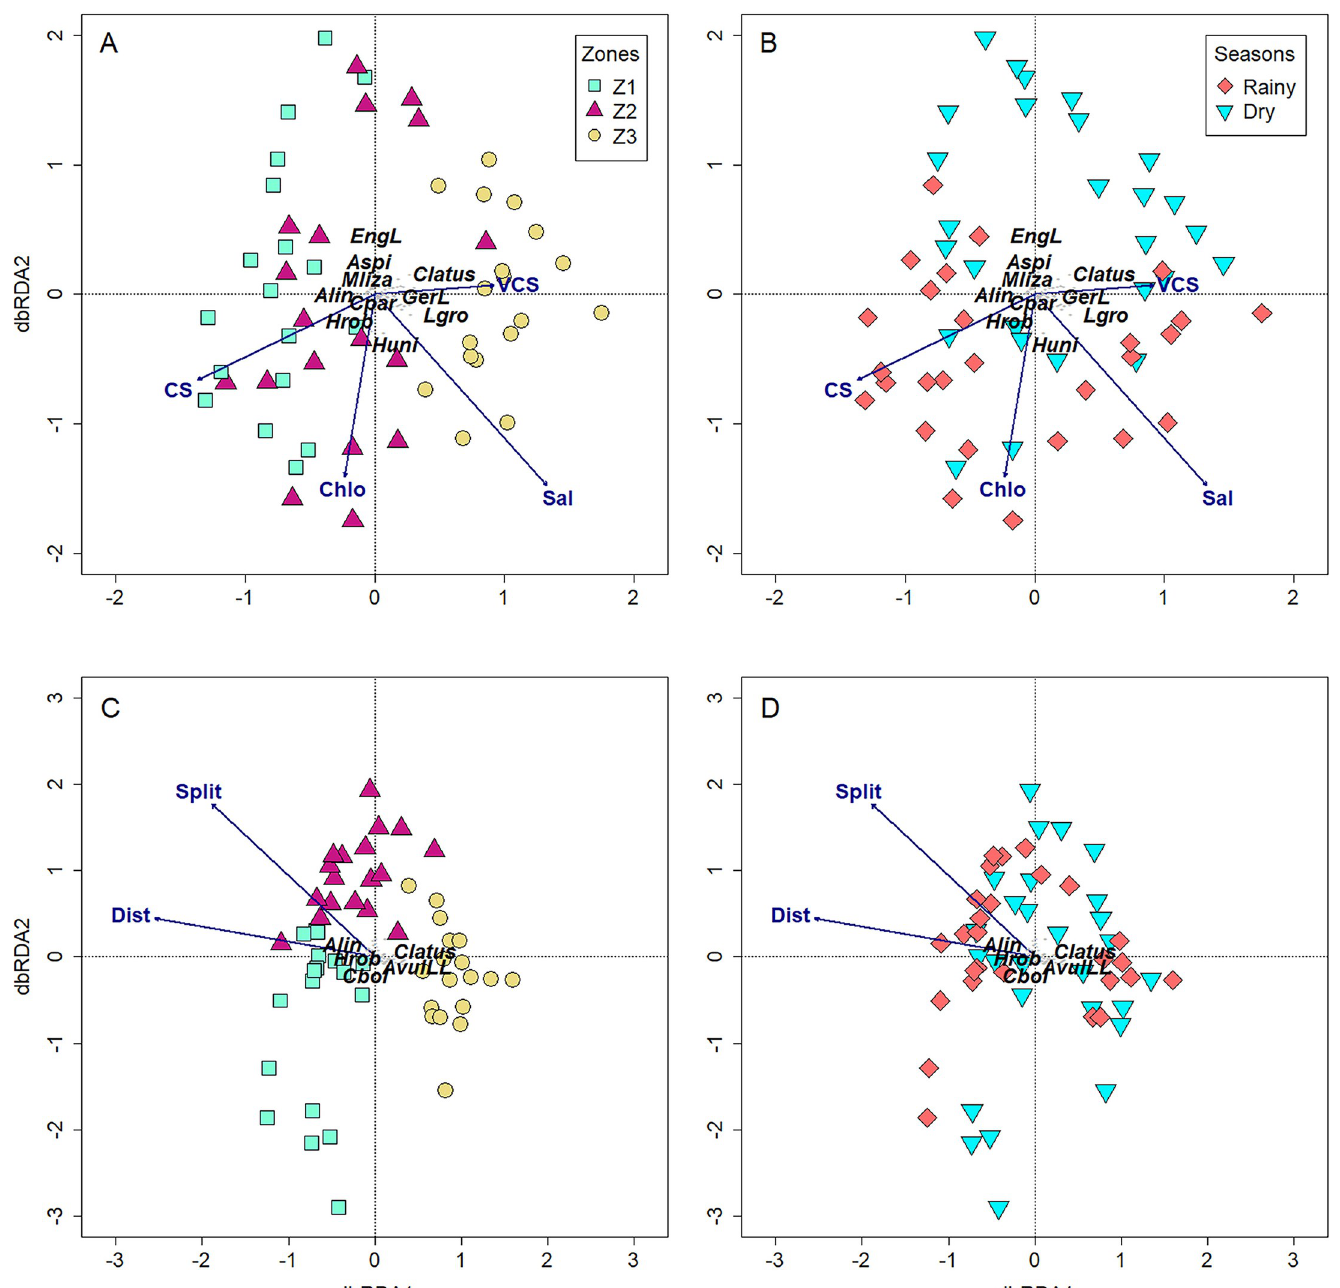
Fig 4. db-RDA ordinations summarizing relationships among environmental (A and B) and landscape (C and D) variables, separately, with fish assemblage β - diversity. Zones: Z1 = aquamarine, Z2 = violet and Z3 = yellow. Seasons: Rainy = red and Dry = lightblue. Variable were coded either by first 3–4 letters or by initials: Chlo = Chorophyll a , CS = Coarse sand, Dist = Distance from the estuary mouth, Sal = Salinity, VCS = Very coarse sand. Species were coded by the first letter of genus or species and first 3 letters of the epithets, except when the epithets were short, then, the names were completely adopted: Alin = Achirus lineatus , AvulLL = Albula vulpes leptocephali larva, Aspi = Anchoa spinifer , Clatus = Caranx latus , Cpar = Centropomus parallelus , Cbol = Ctenogobius boleosoma , EngL = Engraulidae larva, GerL = Gerreidae larva, Hrob = Hyporhamphus roberti , Huni = Hyporhamphus unifasciatus , Lgro = Lycengraulis grossidens , Mliza = Mugil liza .